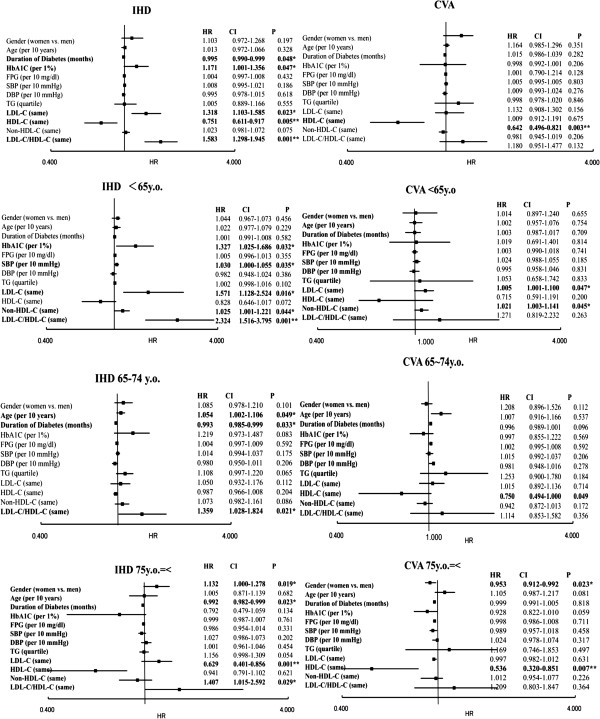
Risk factors for IHD and CVA by Cox multivariate models in representative age groups (IHD, Left; CVA, Right). The upper panels show the analyses of IHD for those younger than 65 years old (Left) and CVA for those younger than 65 years old (Right). The lower panels show the analyses of IHD (Left) and CVA (Right) for those equal to or older than 75 years. HR stands for Hazard Ratio (vertical bar shows 1). Bold characters indicate statistically significant factors. The right side of each figure shows Hazard Ratios and 95% CIs. Because LDL-C/HDL-C interacts strongly with LDL-C and HDL-C and because non-HDL-C interacts with triglyceride and LDL-C, we analyzed non-HDL-C and LDL-C/HDL-C separately. In other words, common factors (gender, age, duration of diabetes, HbA1C, FPG, systolic BP (SBP), and diastolic BP (DBP)), TG, LDL-C and HDL-C were analyzed. Then, non-HDL-C and common factors were analyzed. Finally, LDL-C/HDL-C, common factors and TG were analyzed.